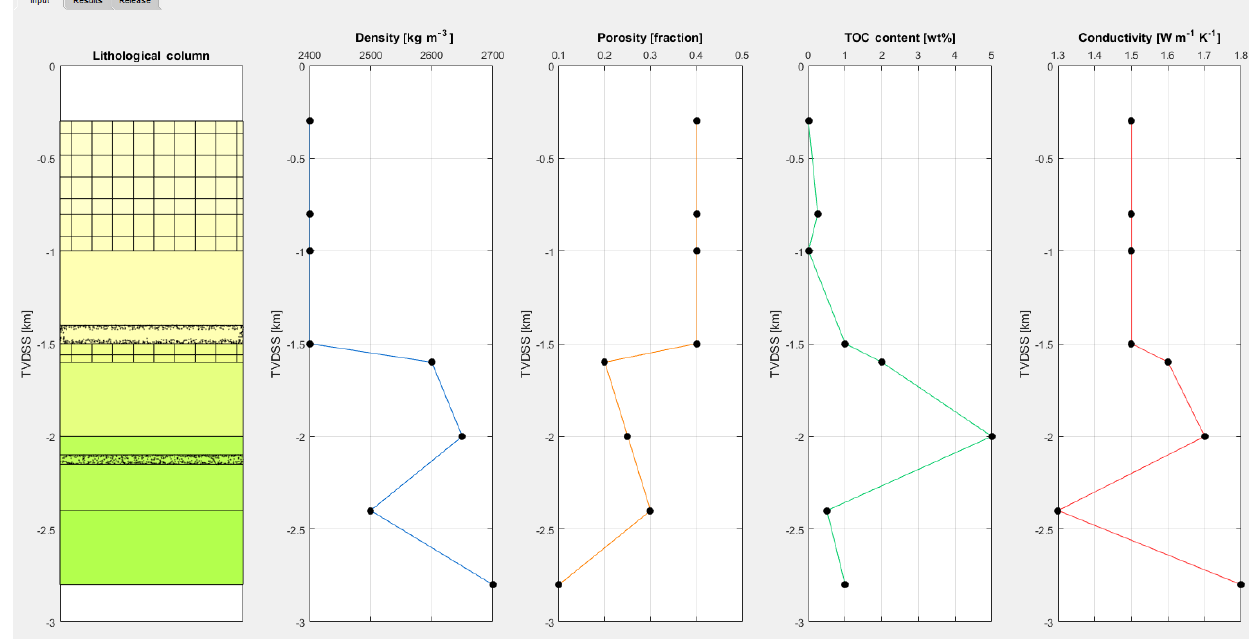
Figure 2. Snapshot of the input tab generated for a hypothetical sedimentary column with two sill intrusions and three eroded layers. Right- clicking a layer in the sedimentary column provides the name and depositional/erosional age of the